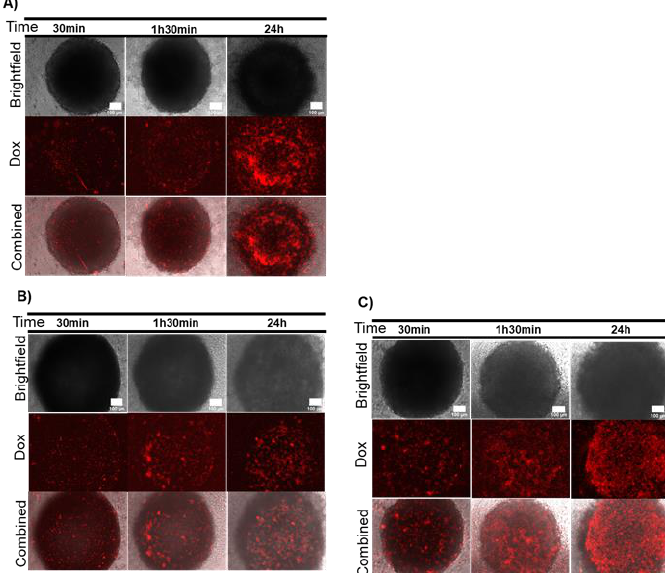
Figure 4. Doxorubicin (Dox) diffusion in spheroids after incubation with AuNP@PEG. ( A ) HCT116 spheroids incubated with 8 nM AuNP@PEG and then with 8 µ M of Dox; ( B ) Dox-resistant HCT116 (HCT116-DoxR) spheroids incubated with 8 nM AuNP@PEG and then with 8 µ M of Dox; ( C ) HCT116-DoxR spheroids incubated with 8 nM AuNP@PEG and then with 120 µ M of Dox. Microscopy images were acquired in Brightfield or with a red fluorescence filter after 30 min, 1 h 30 min or 24 h incubation. The combined images result from the overlap between Brightfield and red filter images. Scale bar corresponds to 100 µ